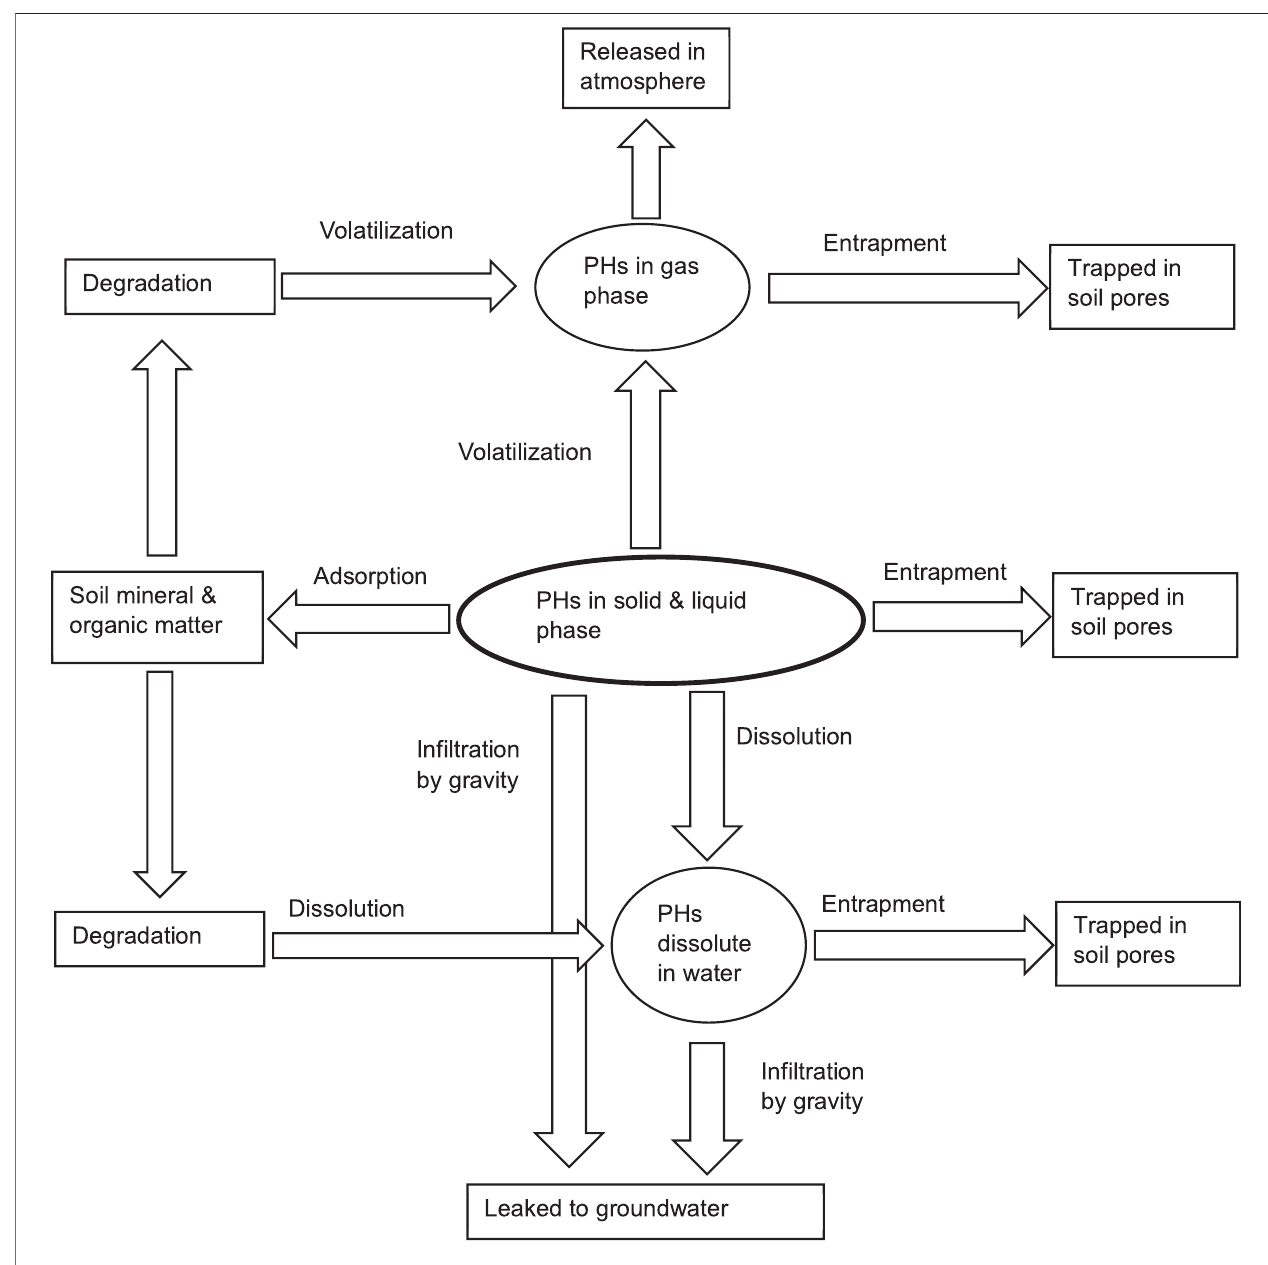
FIGURE 3 | The schematic of the weathering processing of PHs in